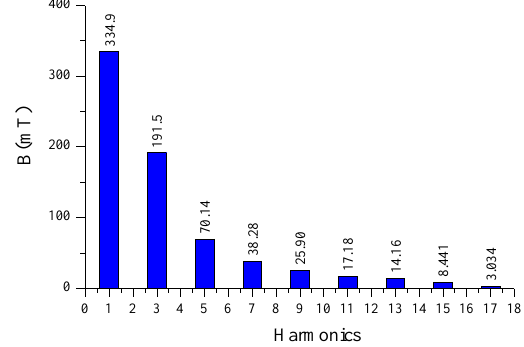
Figure 16. The harmonic amplitude in the PM of the BLDCM.